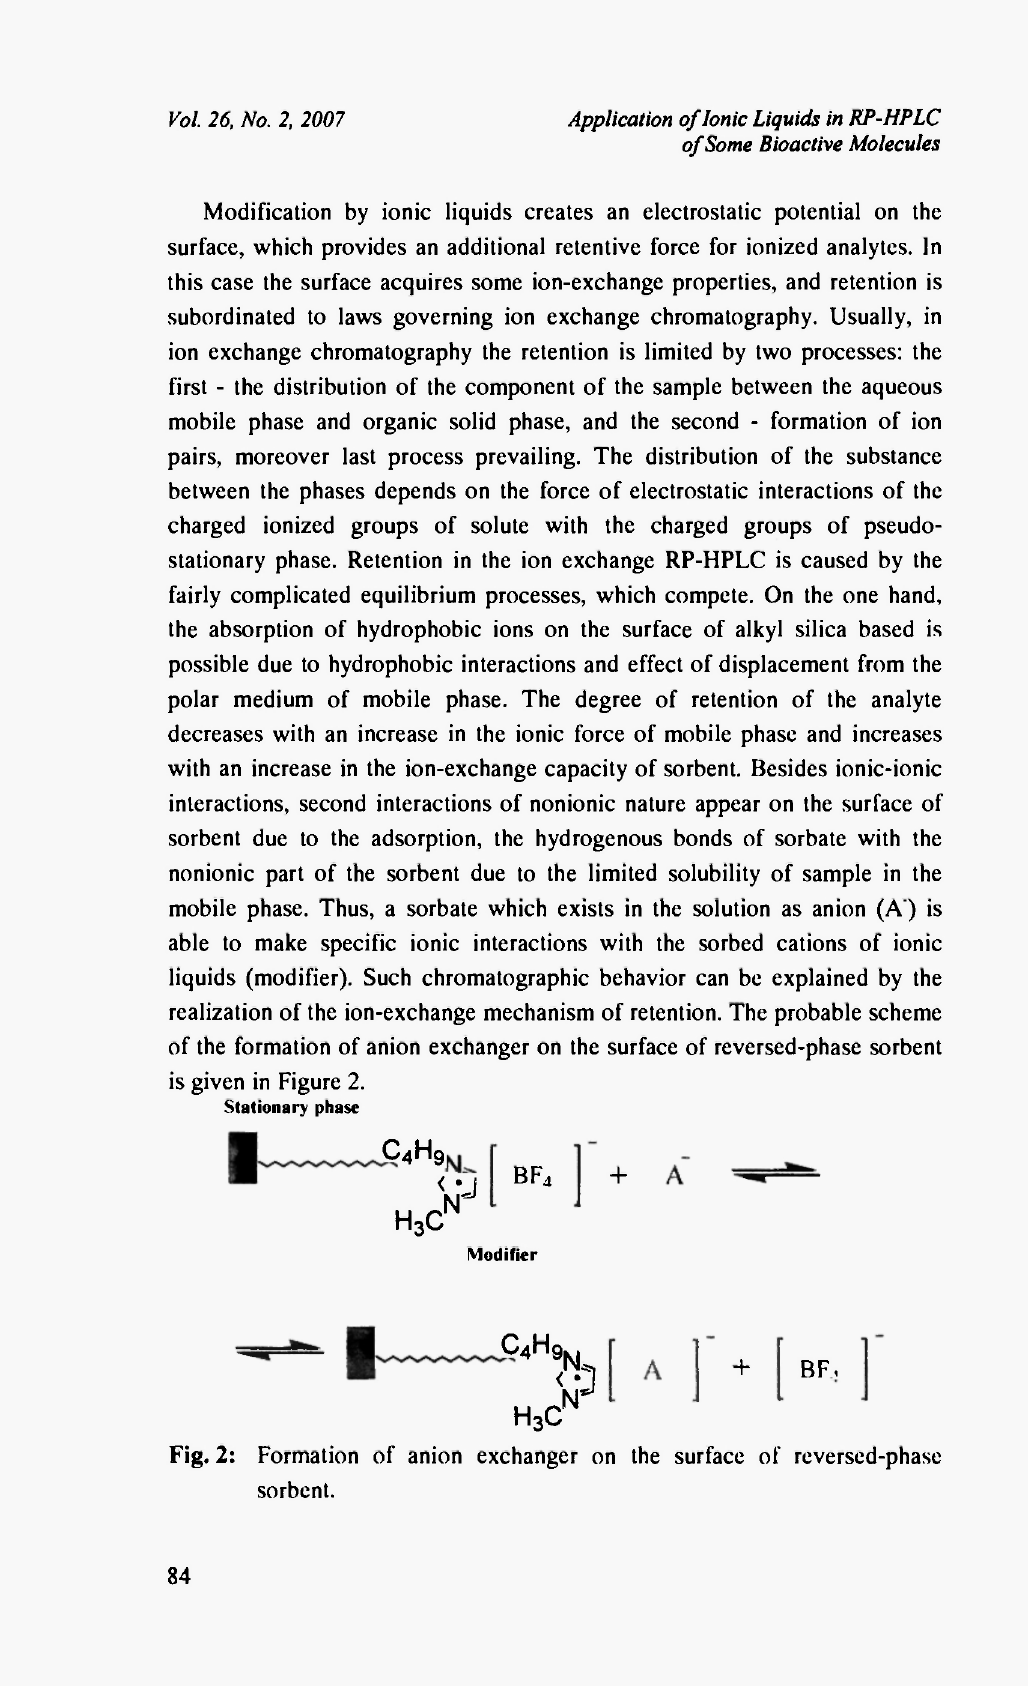
Fig. 2: Formation of anion exchanger on the surface of reversed-phase